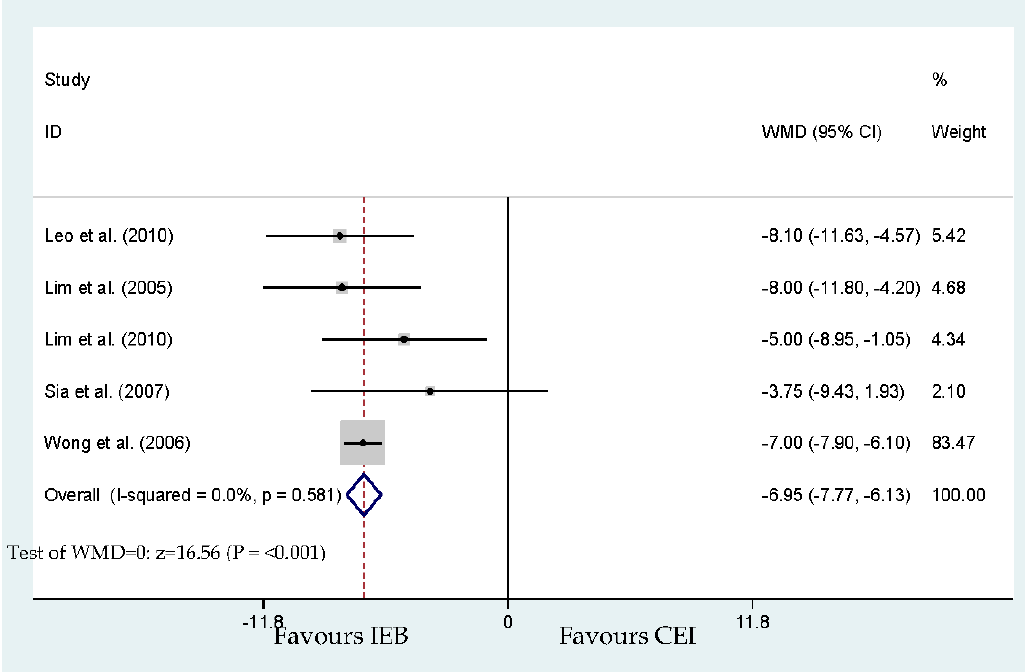
Figure 8. Overall effect for maternal satisfaction (visual analog scale from 0 to 100).